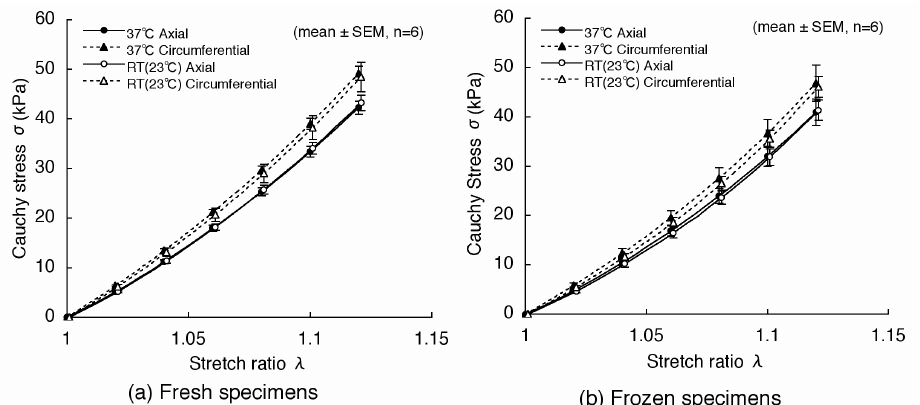
Fig. 6 Comparison of stress-stretch ratio curves of fresh (a) and frozen (b) porcine thoracic aortas. Frozen specimens were kept at –18°C for 2 weeks. The method of the 37°C in an oxygenated Krebs-Henseleit